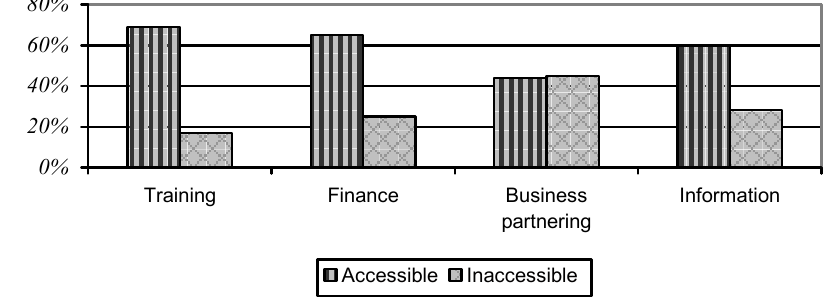
Figure 1: Accessibility of small business support systems